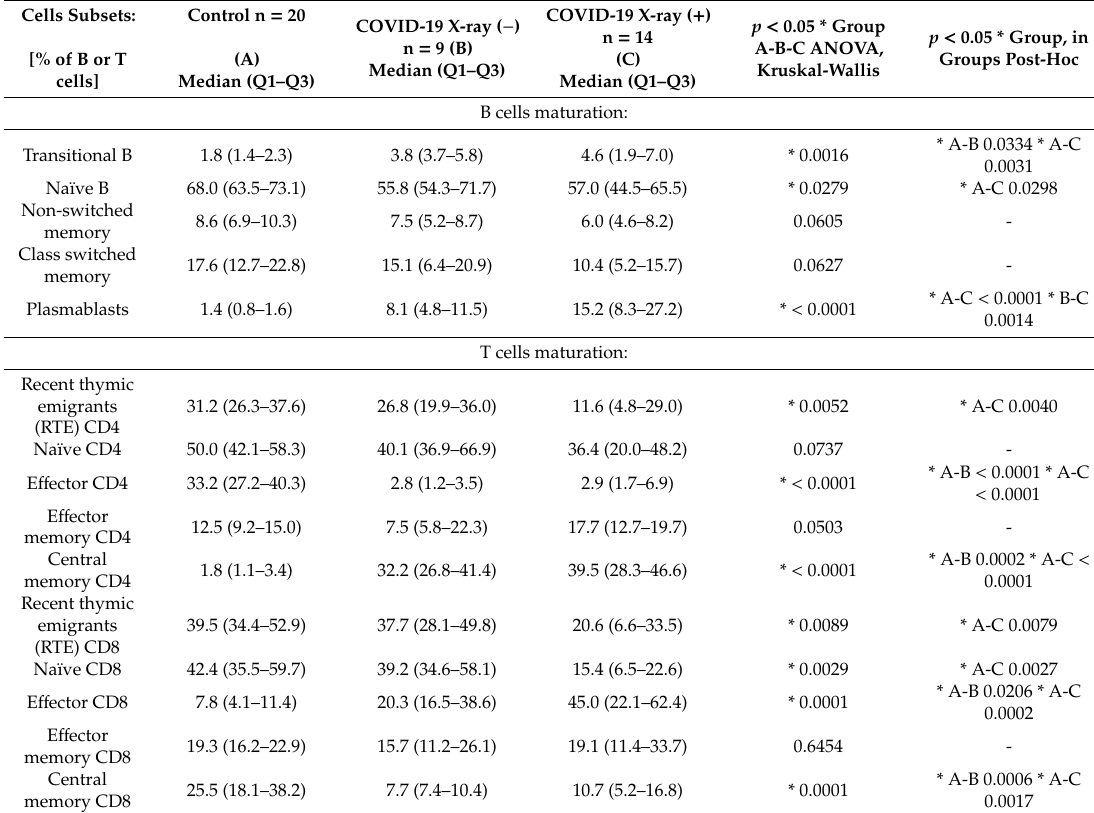
Table 3. Di ff erences in the proportion of B and T lymphocytes maturation between healthy patients ( A ), patients with COVID-19 without interstitial lesions on chest X-ray (( B ): COVID-19 X-ray ( − )) and patients with COVID-19 with interstitial lesions on chest X-ray (( C ): COVID-19 X-ray ( + )). Data expressed as median